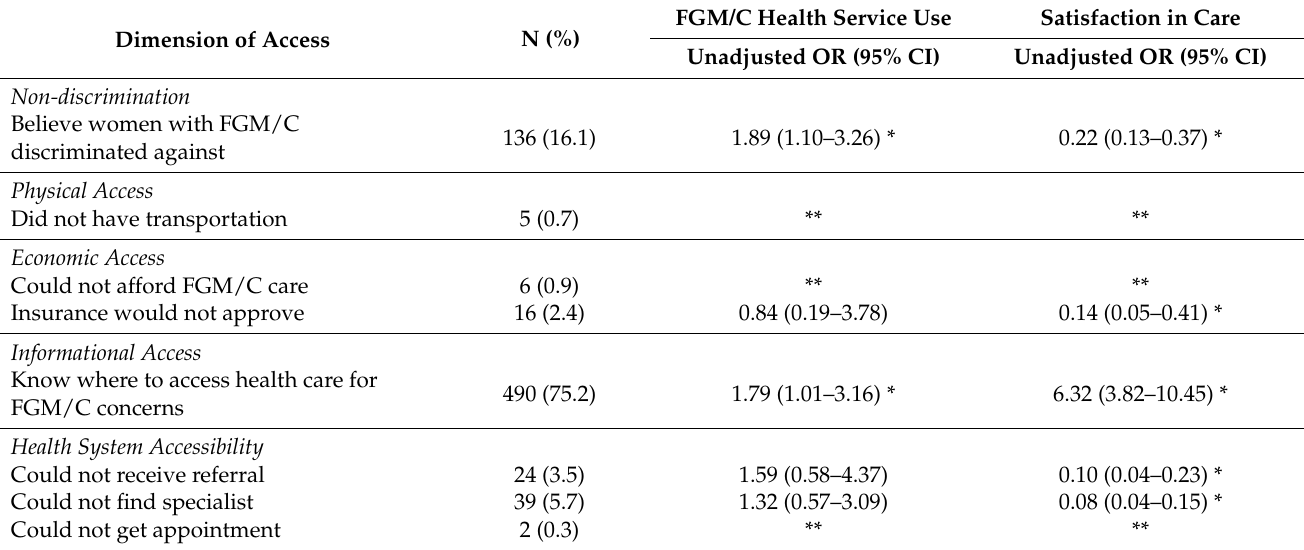
Table 2. Access to care for